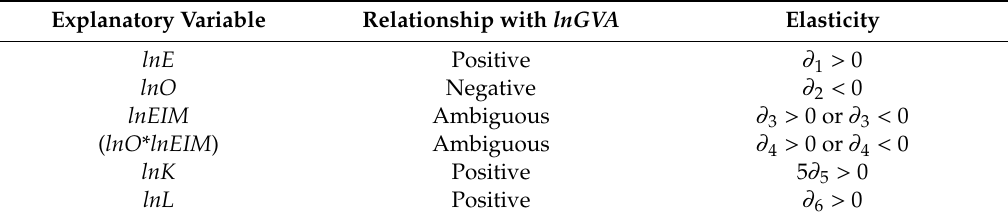
Table 1. Table of hypothesis.